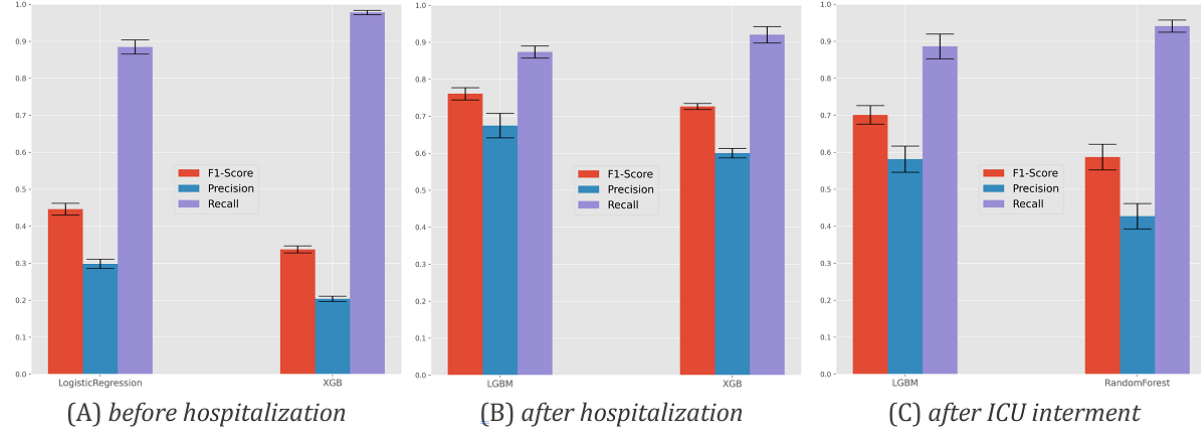
Figure 9. Predictability of the survivability (outcome) of infected individuals at 3 stages. Results for the best F1 predictor (left) and recall-optimized predictor (right) per stage are shown. XGB: XGBoost, LGBM: LightGBM.